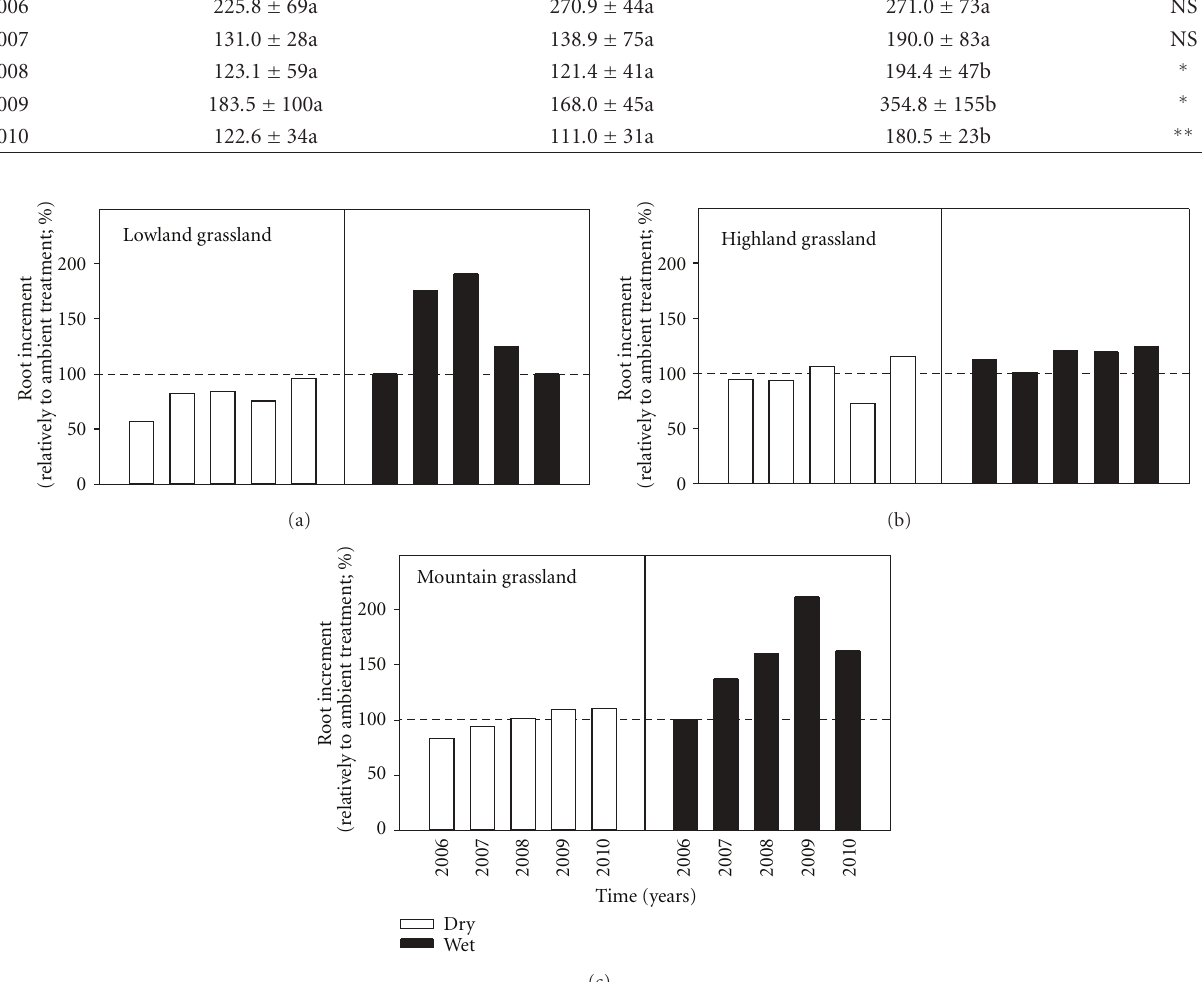
Figure 3: Percentage increase or decrease in yearly root increment (ambient treatment = 100%) in dry and wet treatments recorded in five years